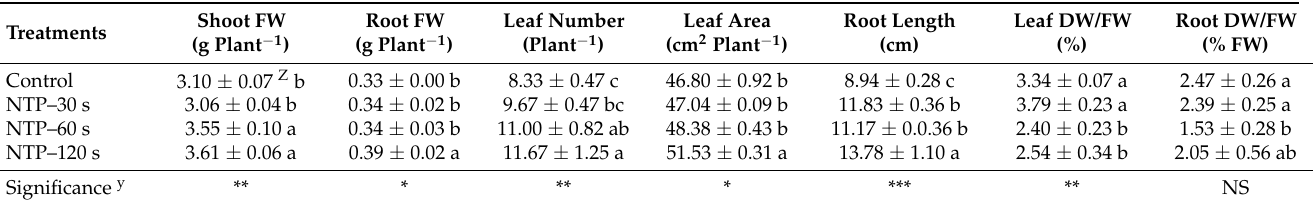
Table 1. Effects of NTP treatment (0, 30, 60, or 120 s every hour) of nutrient solution on shoot and root fresh weight (FW), leaf number, leaf area, root length, and DW/FW percentage ratio in both leaves and roots of baby leaf lettuce plants grown in an indoor hydroponic system for nine days (Experiment